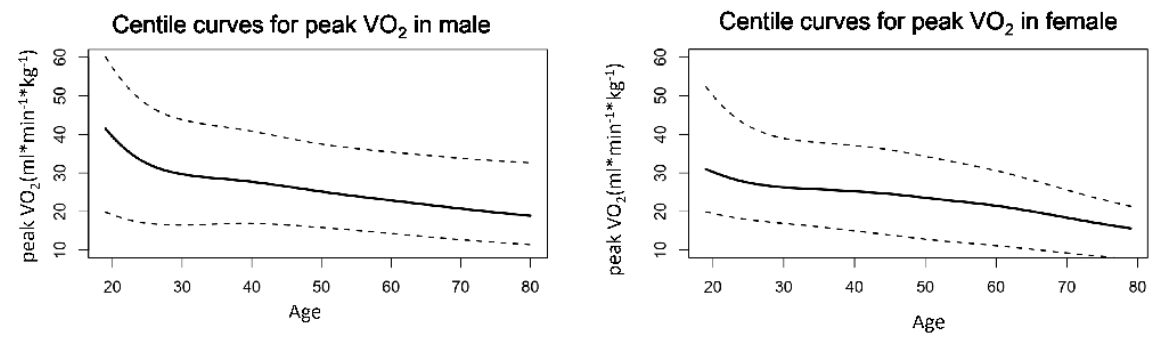
· Figure 2. Centile curves of VO 2peak (mL · min − 1 · kg − 1 ) for men and women. The dashed lines on the top represent the upper limits at 98th, the solid line in the middle represents the median V the dashed lines at the bottom represent the lower limits at 2nd percentile.